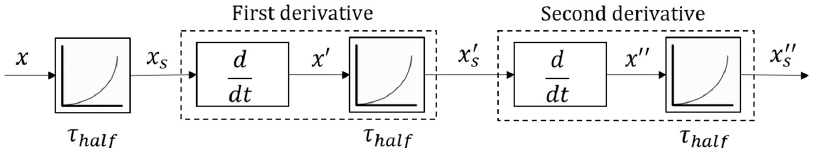
Figure 7. Flow diagram of the improved bout computation. The meaning of each symbol is given in the text.